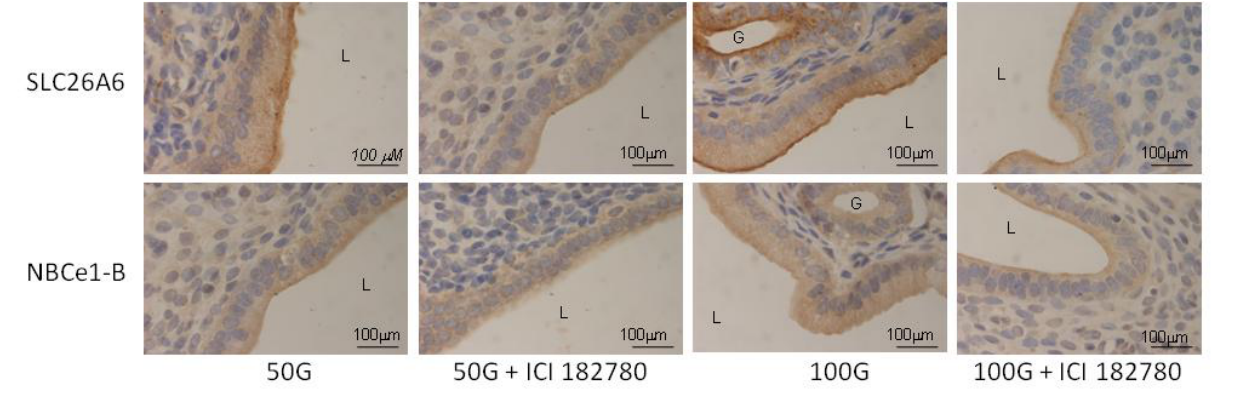
Figure 6. High magnification images (40×) shows the distribution of SLC26A6 and NBCe1-B at the apical and basolateral membranes of the luminal epithelia in rat receiving high doses genistein treatment (50 and 100 mg/kg/day with and without the presence of ICI 182780, an estrogen receptor antagonist). High SLC26A6 immunostaining intensity was seen following 100 mg/kg/day genistein treatment, which was reduced following concomitant administration of ICI 182780. Moderate NBCe1-B immunostaining intensity was observed at the apical membrane of the luminal epithelia following treatment with 100 mg/kg/day genistein. Meanwhile, the absence of immunostaining was seen at the basolateral membrane. ICI: ICI 182780; 50G: 50 mg/kg/day genistein; 100G: 100 mg/kg/daygenistein. L: lumen; G: